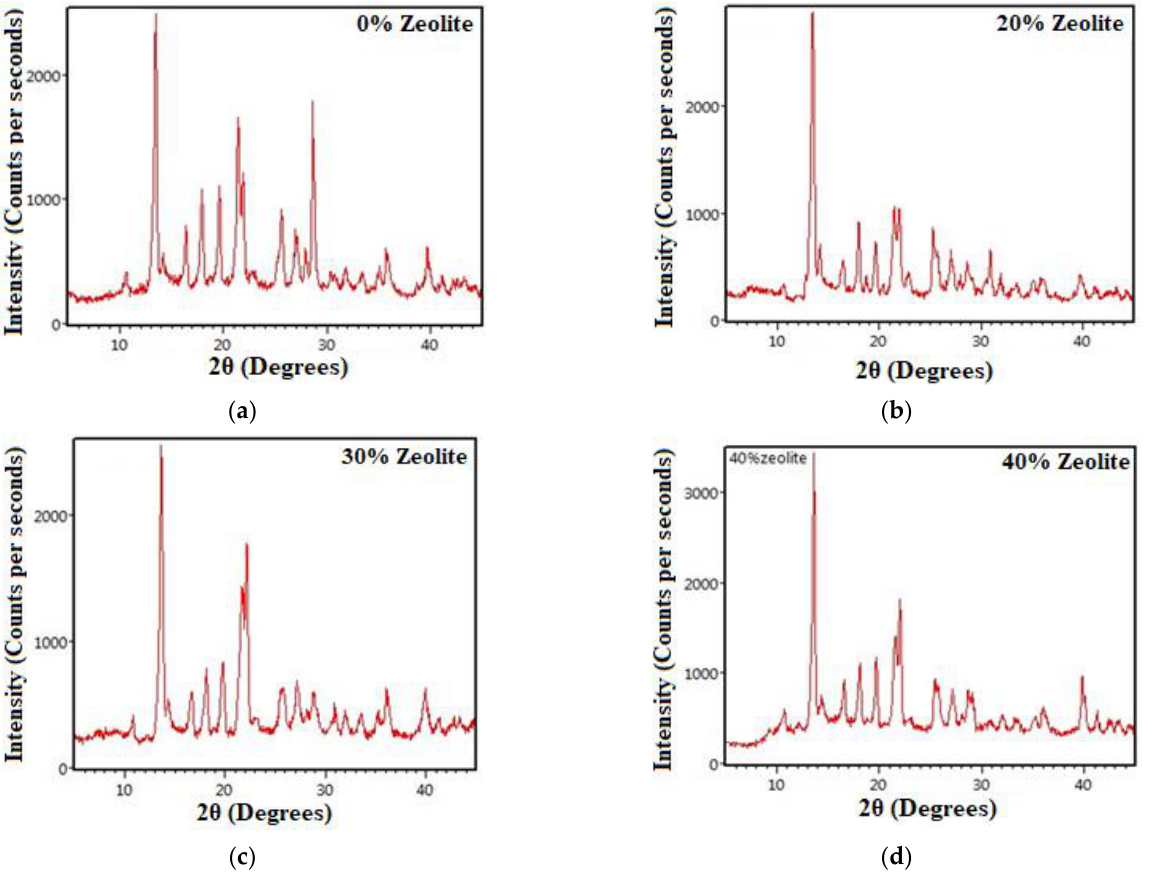
Figure 10. XRD analysis spectrum for samples containing different replacement percentages of zeolite to cement ( a ) 0%, ( b ) 20%, ( c ) 30%, and ( d ) 40% (wt.% of cement).